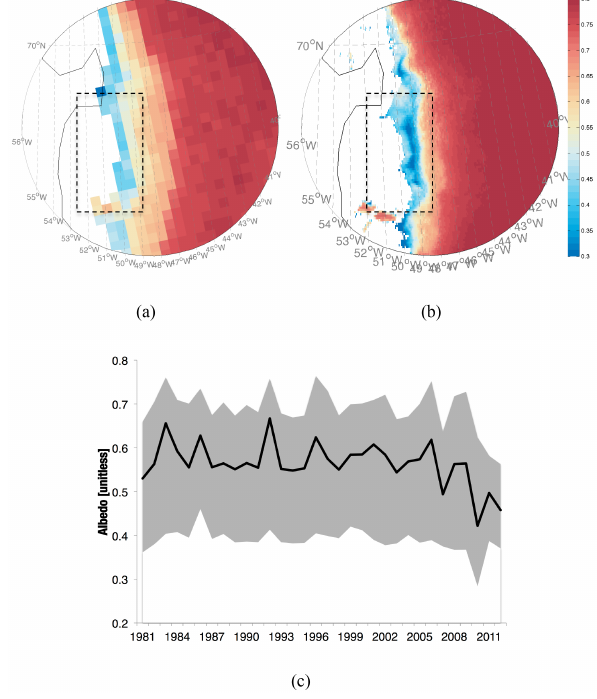
Figure 4. (a) MAR and (b) GLASS mean JJA albedo for the year 2010 over an area including the dark band together with (c) time series of mean JJA albedo for the ice-covered areas in the black rectangle. The black line in (c) shows the GLASS spatially aver- aged albedo, where the top and the bottom of the grey area indicate, respectively, the maximum and minimum albedo within the black box in (b) .